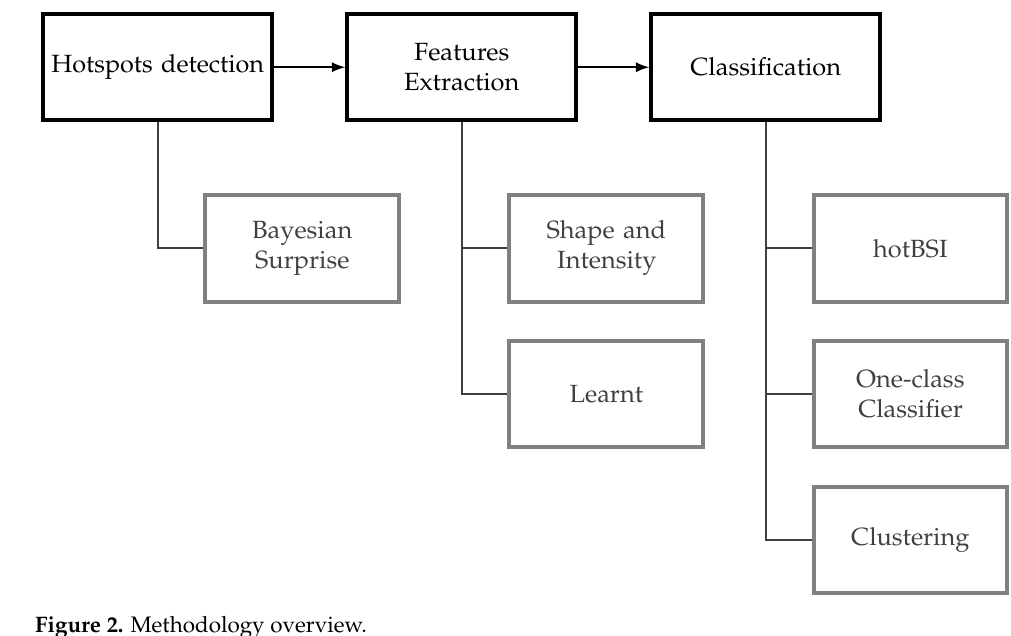
Figure 2. Methodology